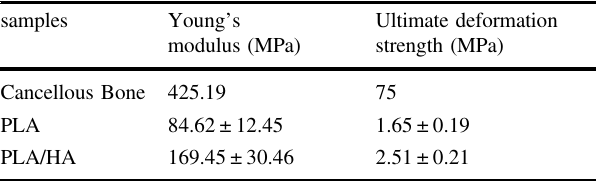
Fig. 3 Preparation and characterization of the scaffolds. Overview of the PLA ( A ) and PLA/HA ( B ) scaffolds. SEM images of the PLA ( C ) and PLA/HA ( D ) scaffolds. The porosities ( E ) and degradation rates Table. 2 Tested values of Young ’ s modulus and ultimate deformation strength of PLA and PLA/HA